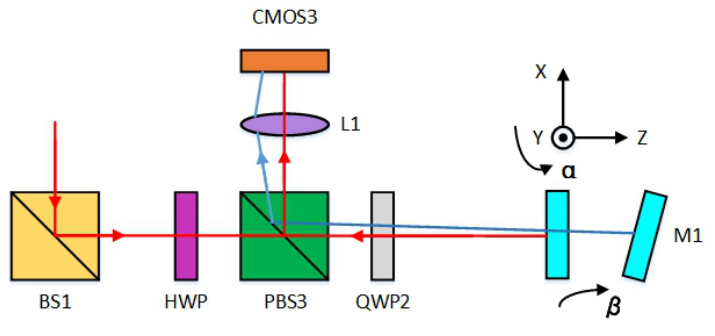
Figure 2. Measurement principle of pitch and yaw.